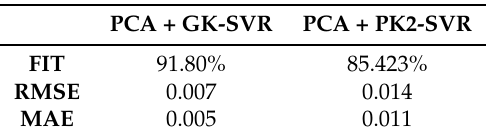
Table 7. SOC estimation results for Route 1.